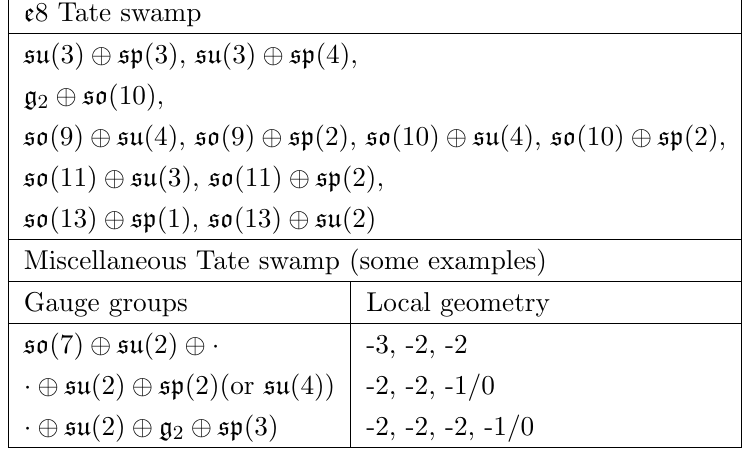
Table 16. Tate tuning swamp: we list all subalgebras allowed by the \ E 8 rule" that however can not be realized by Tate tunings. We also give some examples of the tuning patterns we found that do not violate global symmetry constraints but that can not be realized by Tate tunings (i.e. violate Tate-Zariski